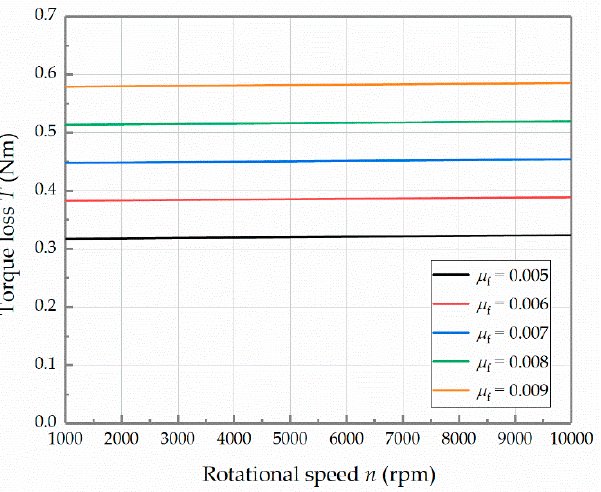
Figure 15. Curves of the torque loss with respect to the rotational speed at different friction coeffi ‐ cients.